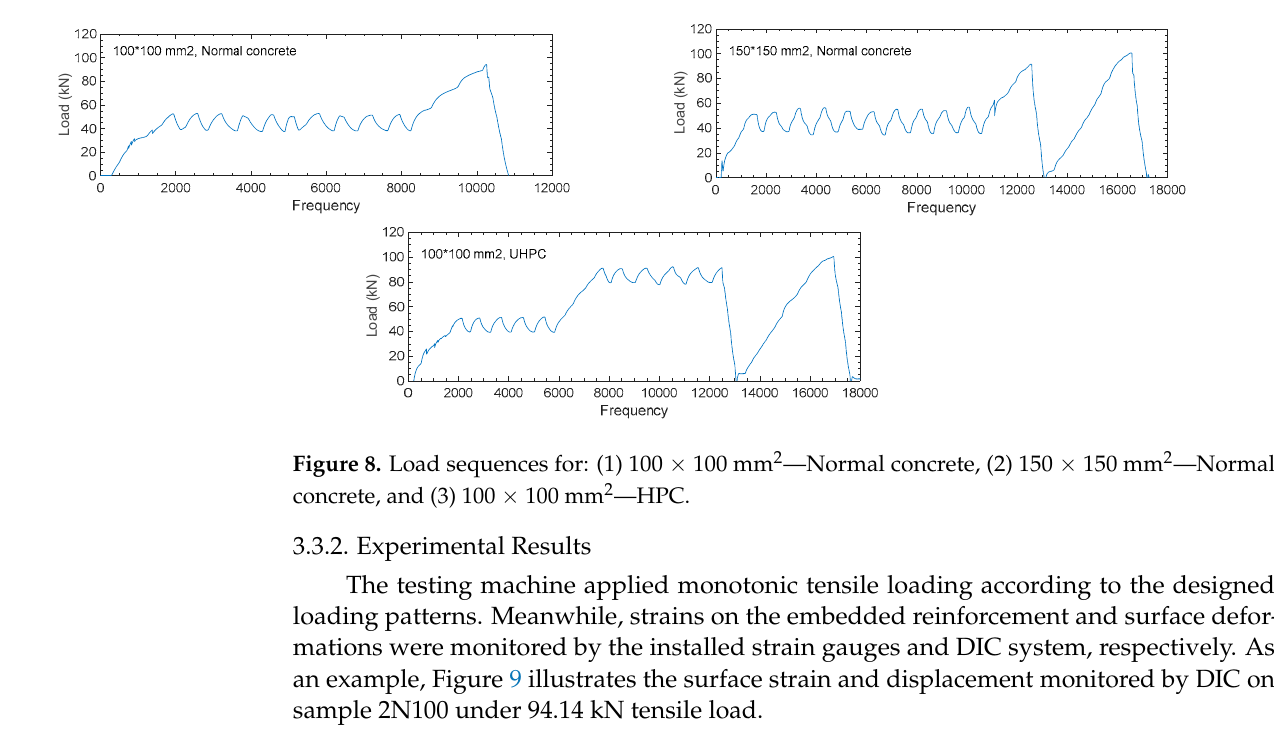
Figure 9. Monitored surface strain and displacement on sample 2N100 under 94.14 kN tensile load. Appearing cracks can be detected as a jump in the surface displacement [15]. Figure 10 presents the location of four propagating cracks on 2N100, in order of propagation, under six di ff erent loading levels. Accordingly, Table 4 summarizes the loading levels reached by the testing machine at the time that cracks formed for all specimens. As can be seen, due to the higher friability of HPC samples compared to NC samples, more cracks appeared at higher loading levels.